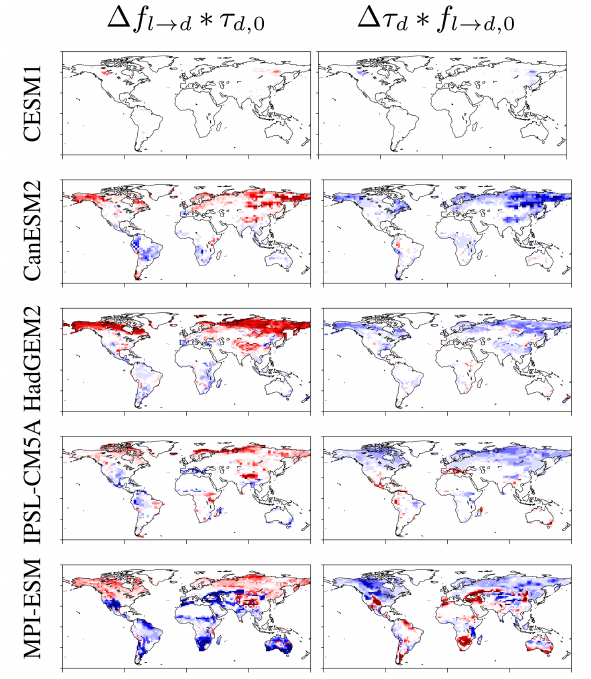
Figure 11. Responses of linearized equilibrium dead carbon pools (kgCm − 2 over the interval of CO 2 doubling) in radiatively coupled (esmFdbk1) run. Left column shows productivity-driven changes to c C d . Right column shows turnover-driven changes to c C d .